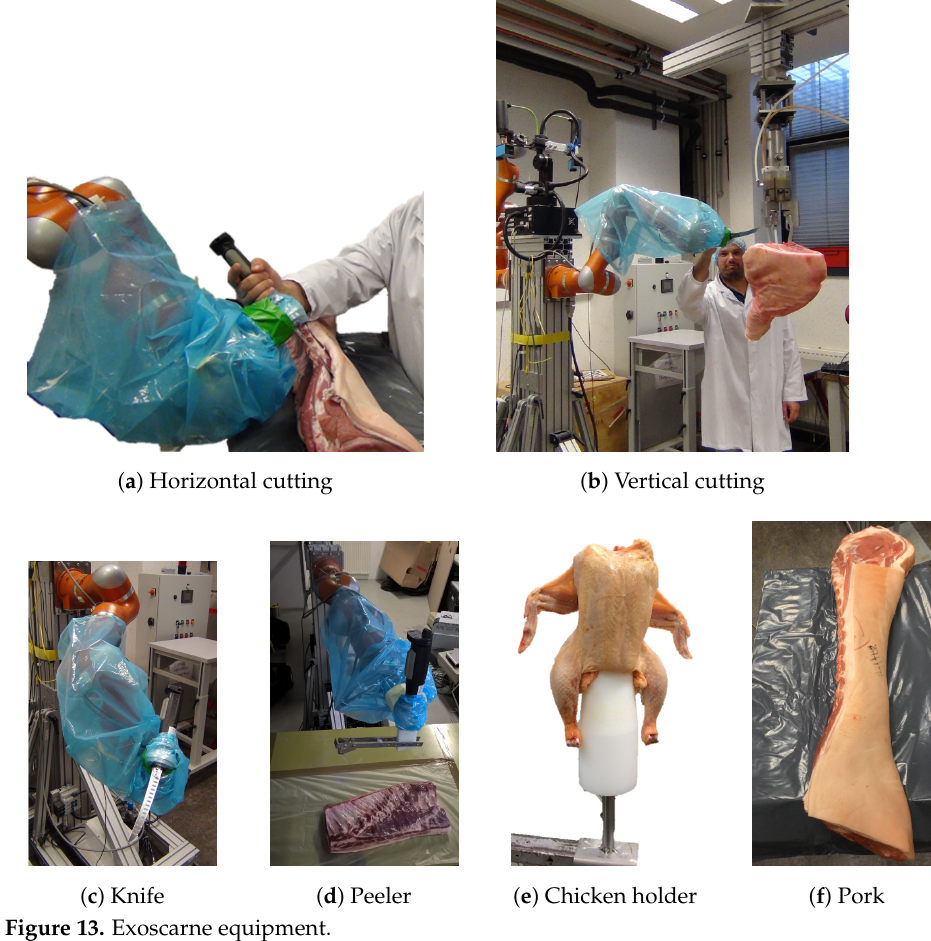
Figure 13. Exoscarne